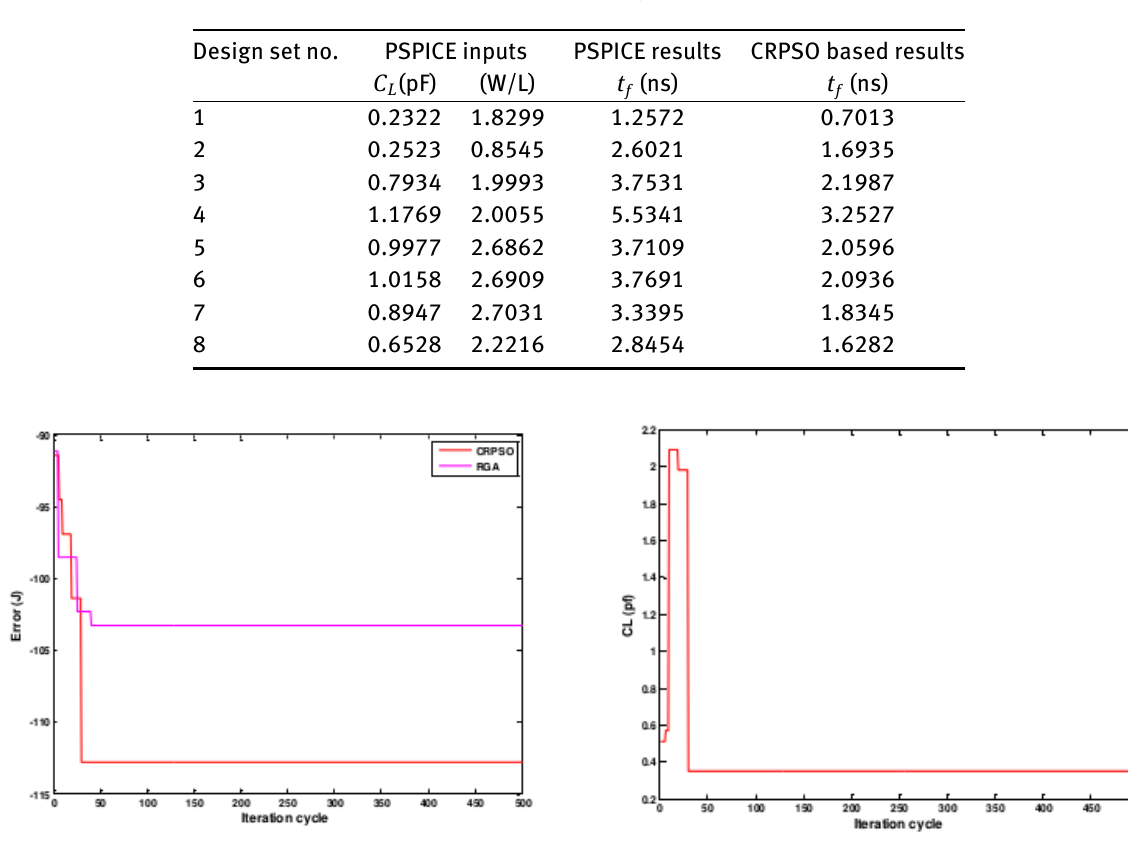
Figure 7: Plot of C L versus iteration cycle for the eighth design set of CRPSO for Case